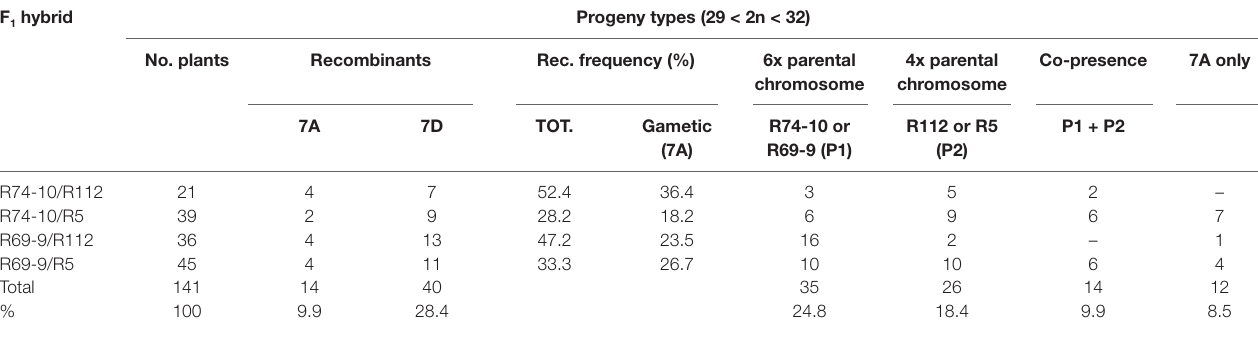
TABLE 3 | Recombination frequency and genotypes isolated in the cross progeny to durum wheat cv. Simeto of pentaploid F 1 s (6x recombinants, R74-10 or R69-9 × 4x recombinants, R112 or R5). F 1 hybrid